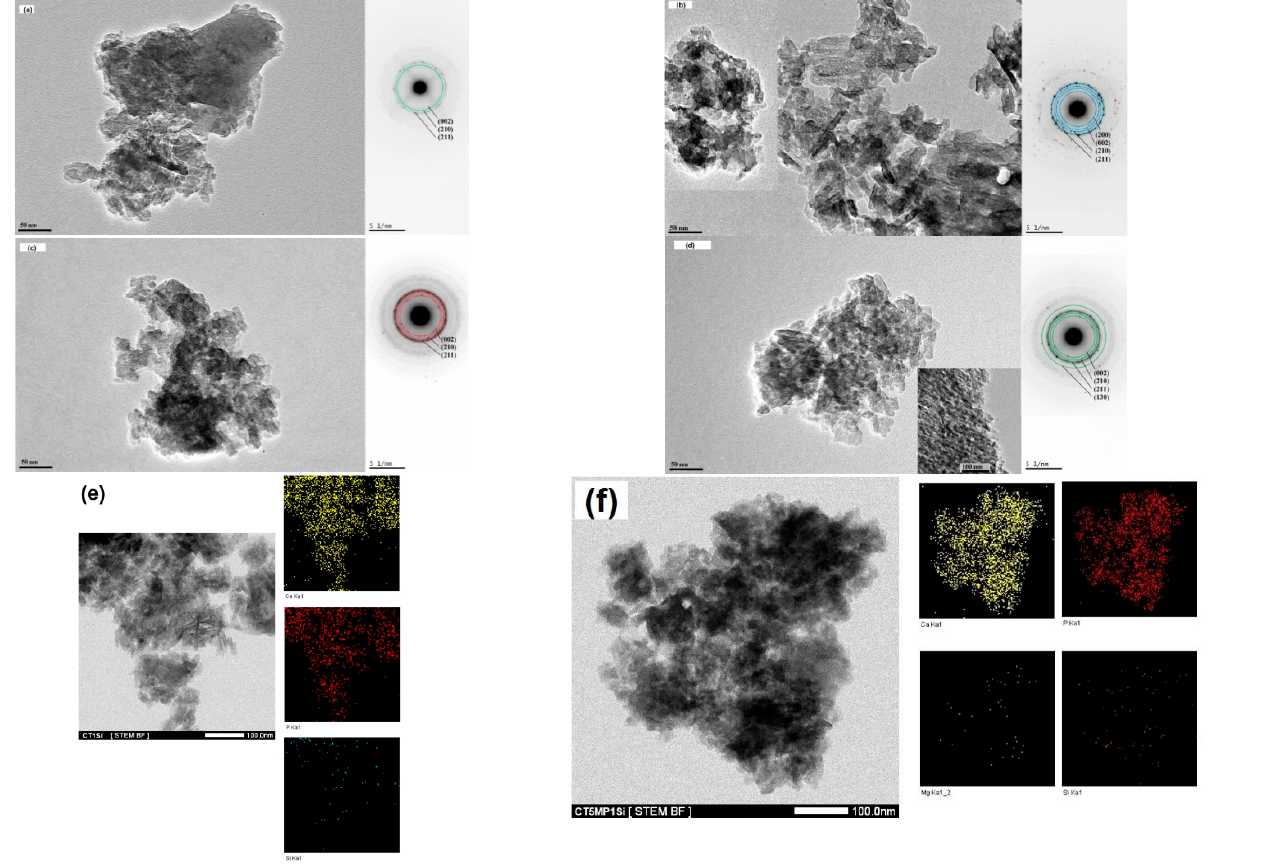
Figure 4. Morphology and SAED of hydroxyapatite nanoparticles in CT ( a ), CT1Si ( b ), CT5MP ( c ), and CT5MP1Si ( d ) observed using TEM and STEM/EDX analysis (mapping) of elements in CT1Si ( e ), CT5MP1Si ( f